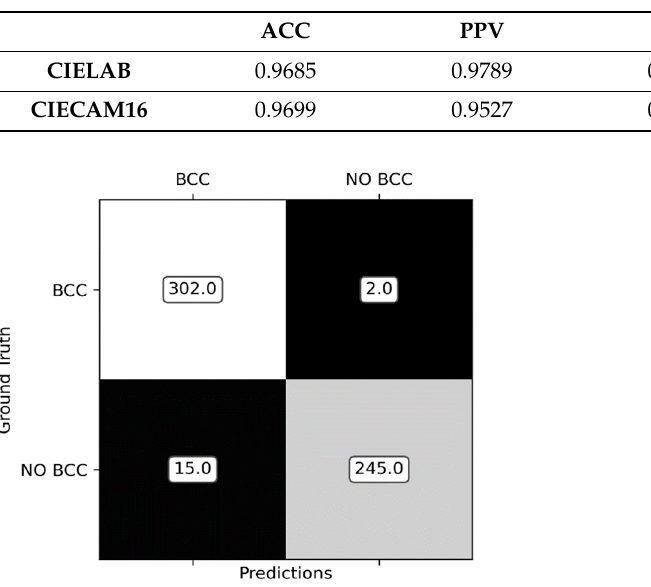
Table 4. Results of the classification into BCC versus non-BCC. ACC: accuracy; PPV: positive predictive value; SPEC: specificity; SENS: sensitivity.